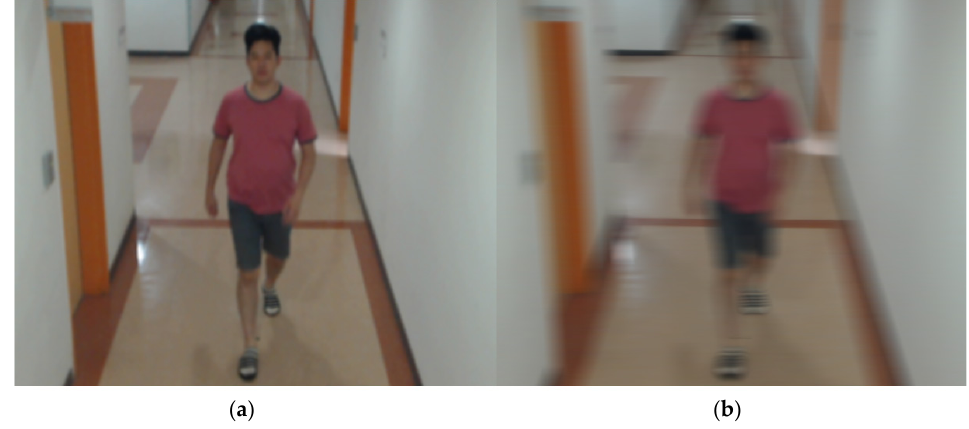
Figure 1. Examples of blurred images captured by an indoor surveillance camera: ( a ) optical-blurred image; ( b ) motion-blurred image.